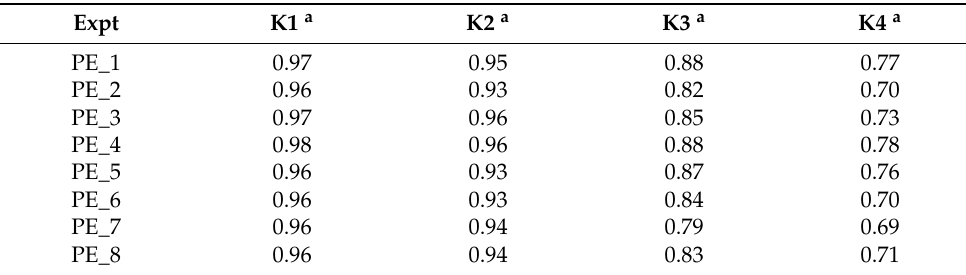
Table 2. Correlation coefficient and index of agreement for the 8-fold cross-validation DCIM experi-